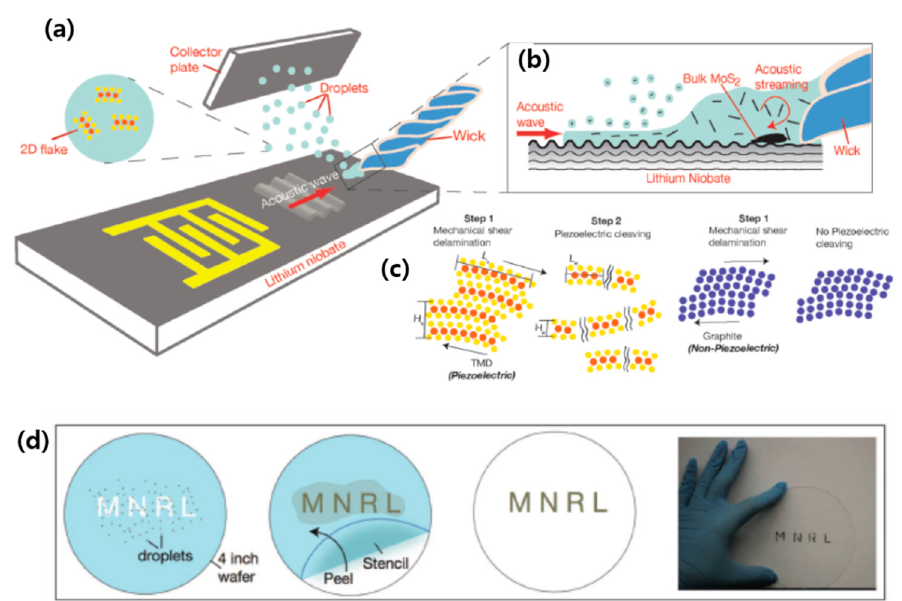
Figure 11. ( a ) Schematic of a chip – scaled piezoelectric device to illustrate the process of 2D flake exfoliation, ( b ) magnification of the schematic that displays dispersion wicking and generation of acoustic streaming, ( c ) schematic illustration of the exfoliation mechanism for 2D nanosheets with piezoelectric and without piezoelectric property, ( d ) schematic illustration of the process for simultaneous exfoliation of 2D nanosheets and stencil printing. Reprinted with permission from reference [21], copyright 2018, John Wiley and Sons.